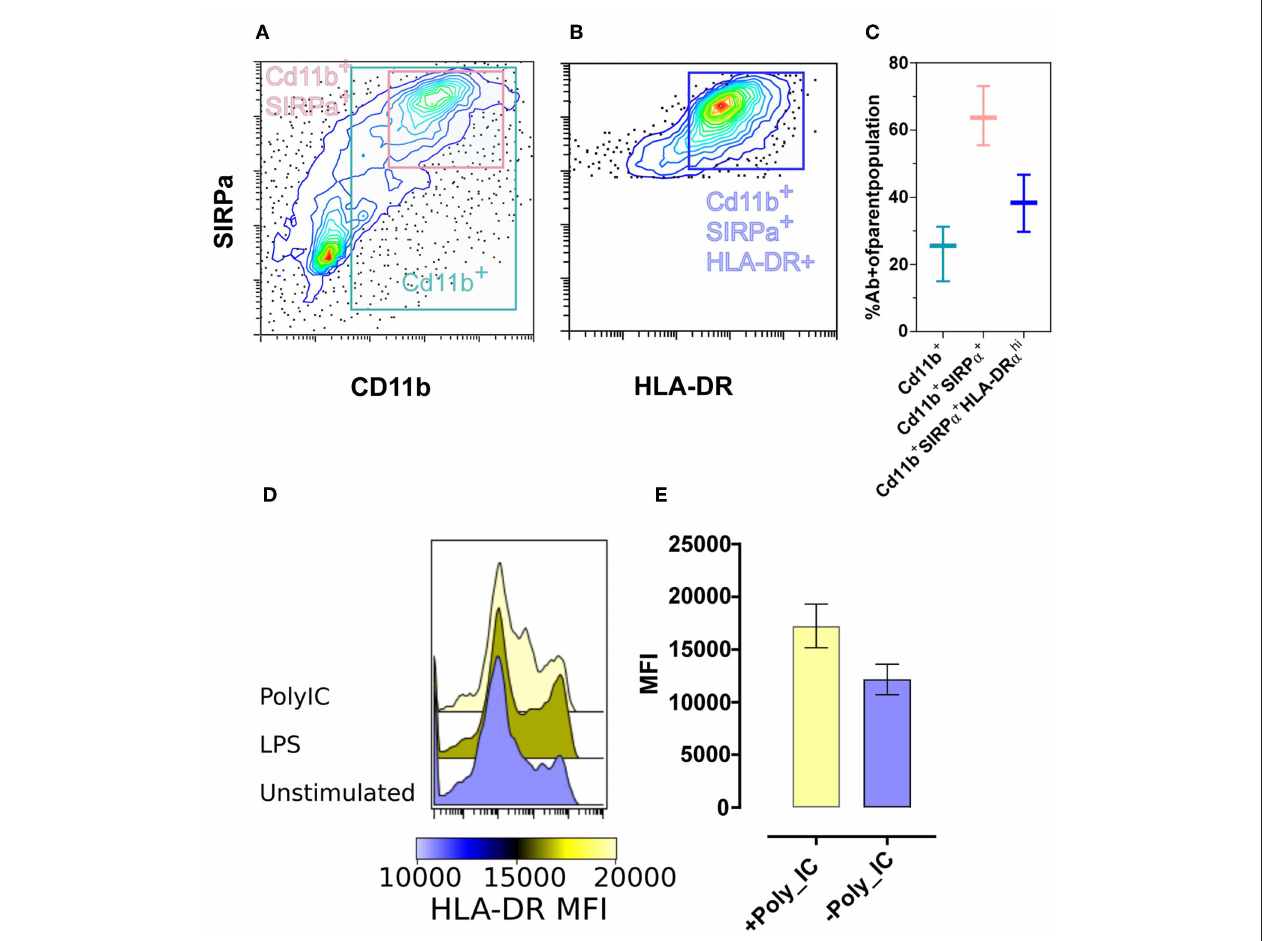
FIGURE 5 | Phenotype and reactivity of M. condylurus BMDCs. BMDC phenotype CD3 ε -, CD79 α -, Cd11b + was measured with flow cytometry. BMDC cultures stained with the markers Cd11b + , SIRP α + , and HLA-DR α + are portrayed in contour plots (A,B) and the percent of each cell type from cultures of three different wild caught M. condylurus are shown (C) . BMDC cultures at day 6 were treated with or without Poly IC and LPS and the median fluorescence intensity for HLA expression of SIRP α + gated cells are shown in (E) for three separate cultures with standard error and representative histograms (D)